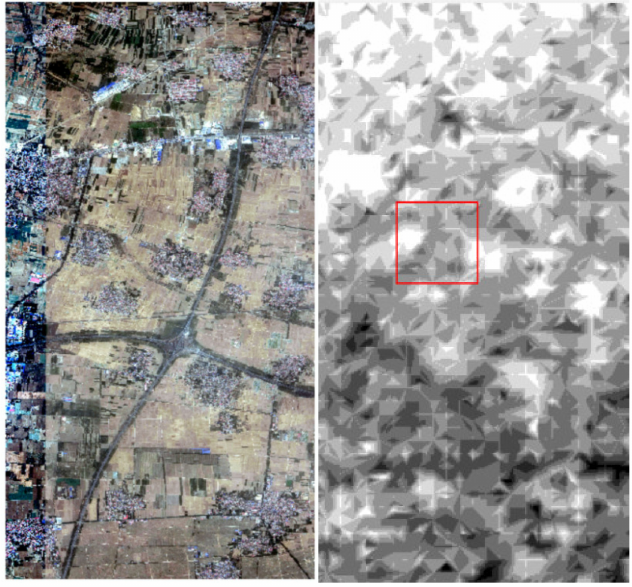
Figure 6. DOM (0.5-m resolution) and DEM (90-m grid) of SuperView-1. After the matching process, images from orbit 154 and the dense matching points were utilized for single-image calibration and verification experiments. Comparison